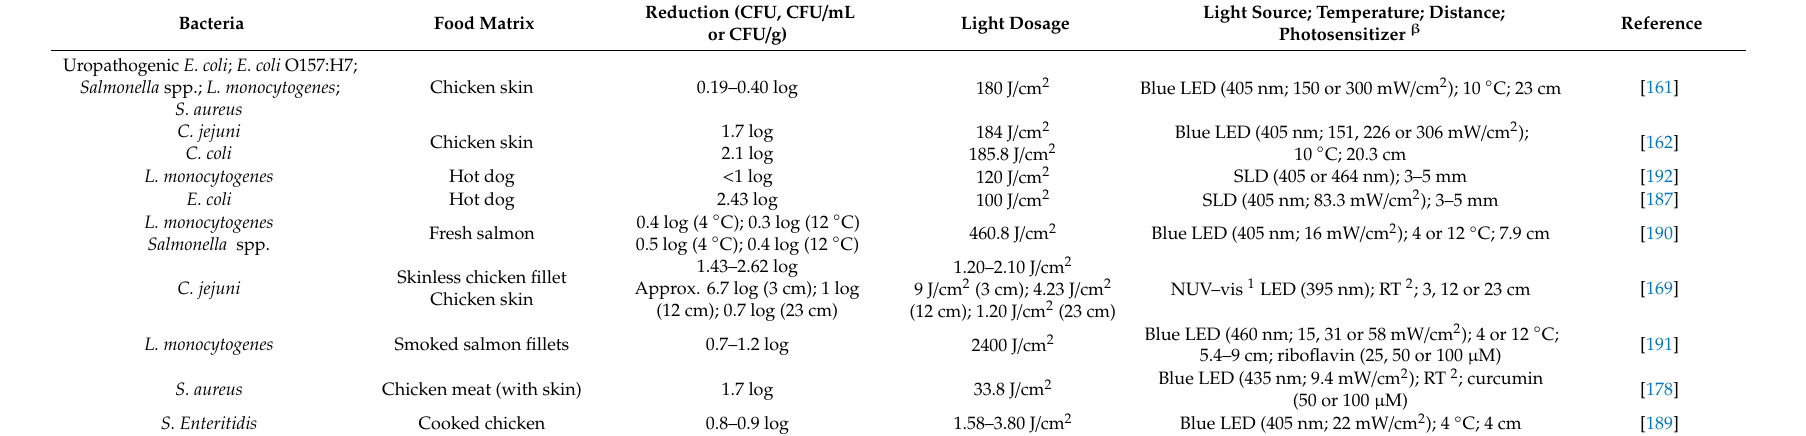
Table 4. Blue light inactivation of pathogenic bacteria in meat and seafood